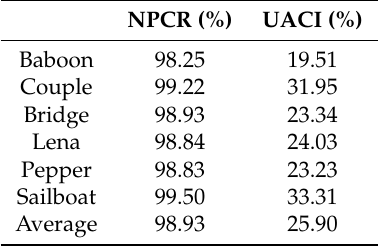
Table 3. NPCR and UACI of sample images for the proposed